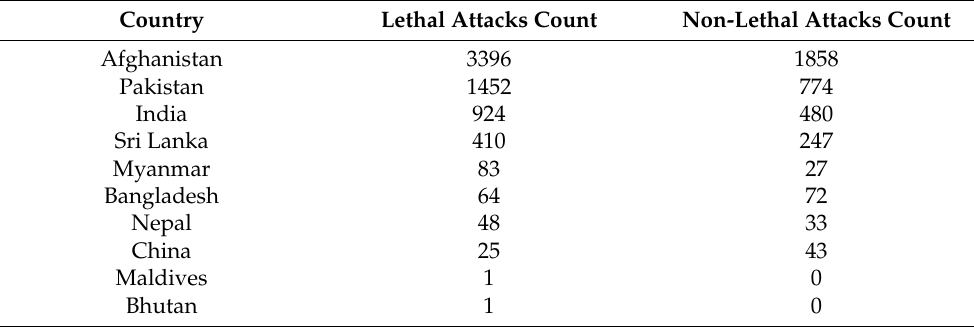
Table 5. Country-wise lethal & non-lethal attack counts in the Attacks of Interest